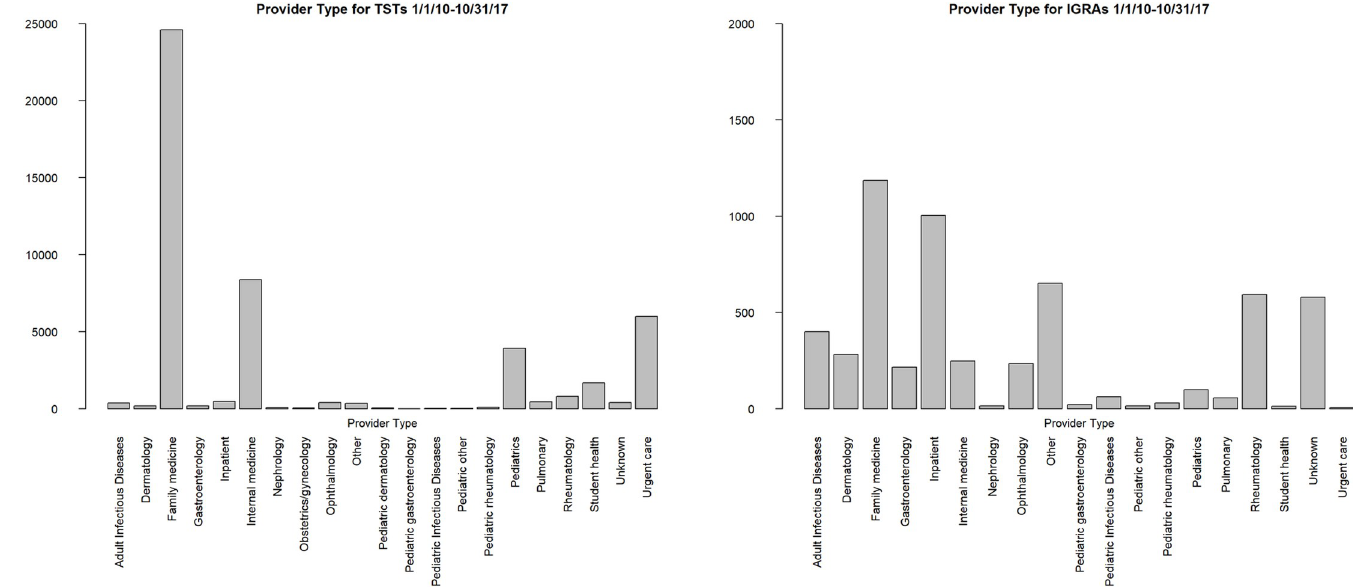
Fig 2. Provider type ordering TSTs and IGRAs in the Duke University Health System, January 1, 2010 to October 31, 2017.